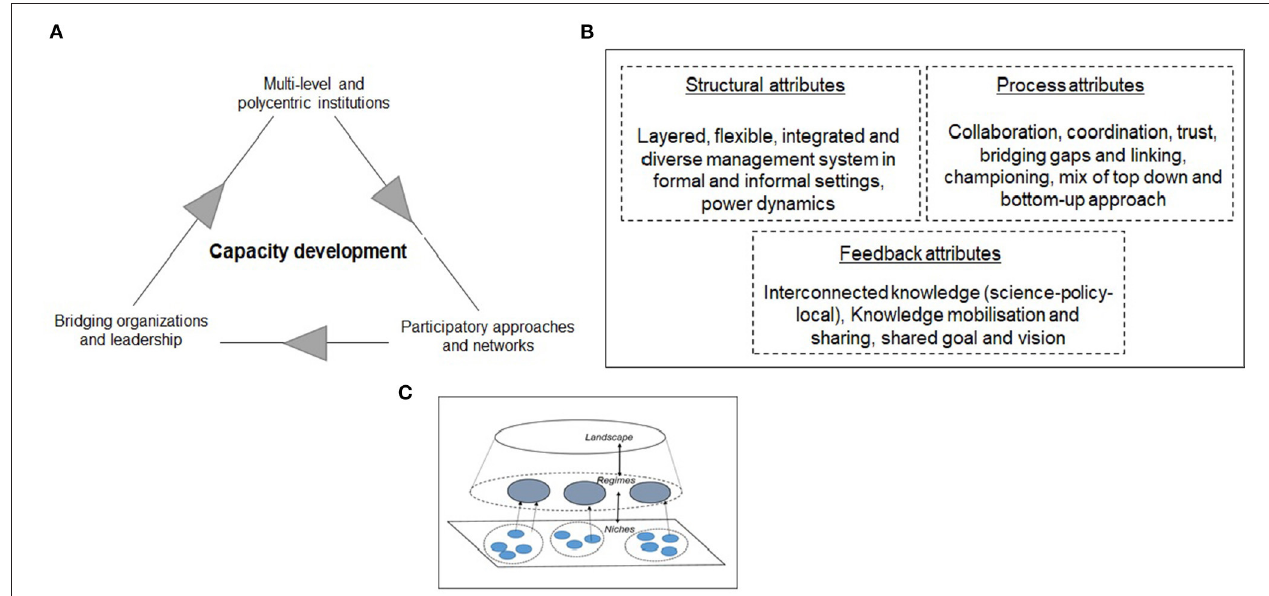
FIGURE 1 | Adaptive capacity attribute framework: (A) Enablers for change, (B) key adaptive governance attributes emerging from the global South context (adapted from Yasmin et al., 2019) (C) multi-level perspective (MLP) proposed by Rip and Kemp (1998), Rotmans et al. (2001), and Berkhout et al.